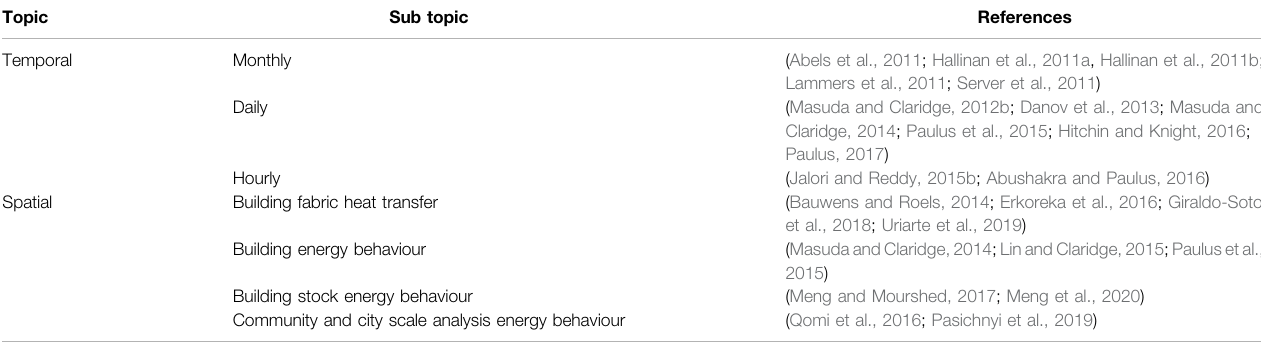
TABLE 3 | Regression-based approaches for operation phase performance analysis.